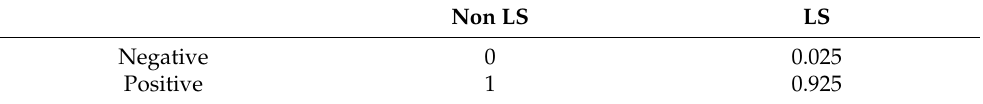
Table 8. Value of GT before and after applying Label Smoothing (SCH).